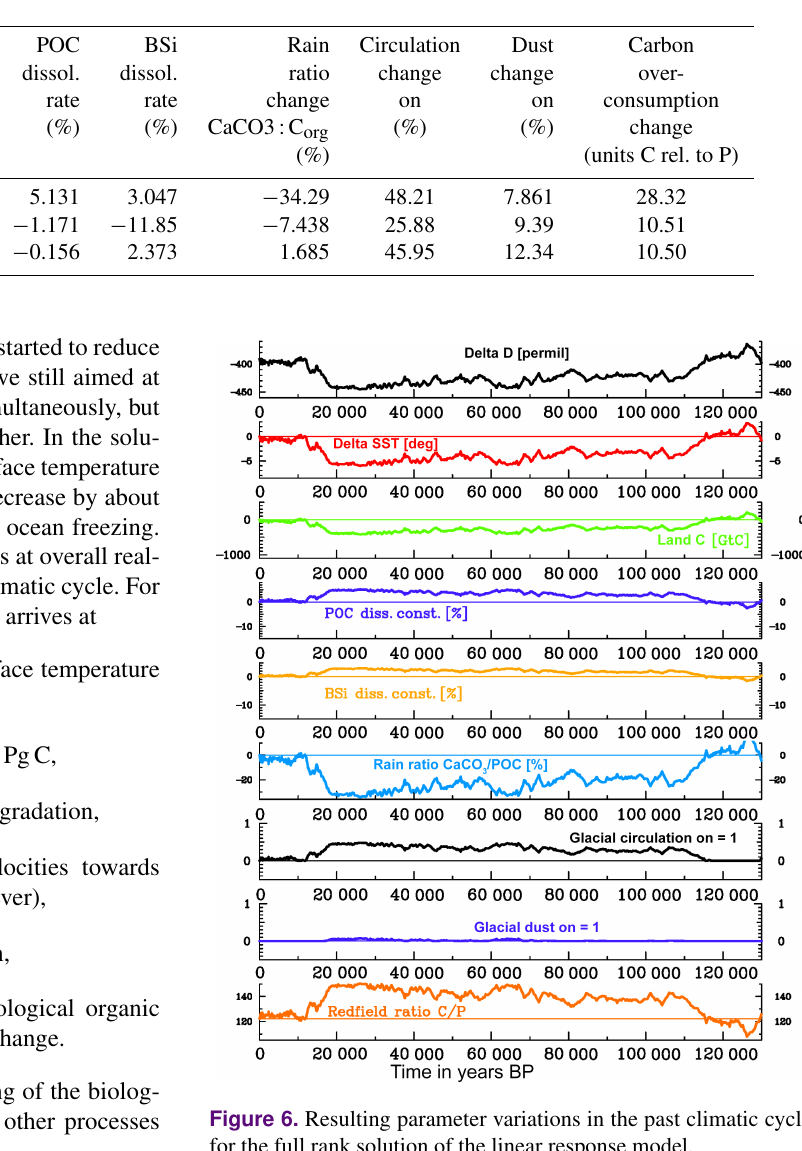
Figure 6. Resulting parameter variations in the past climatic cycle for the full rank solution of the linear response